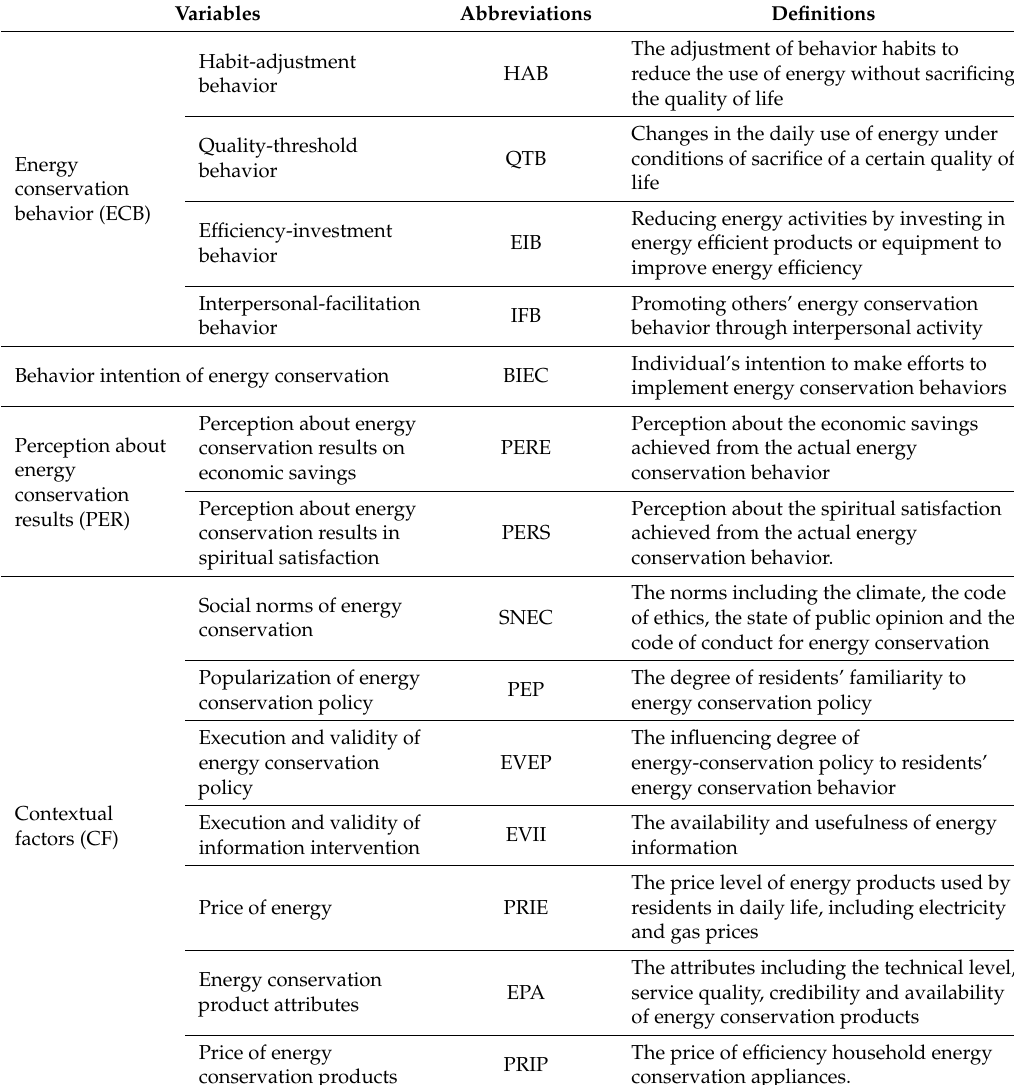
Table 1. Abbreviations and definitions of